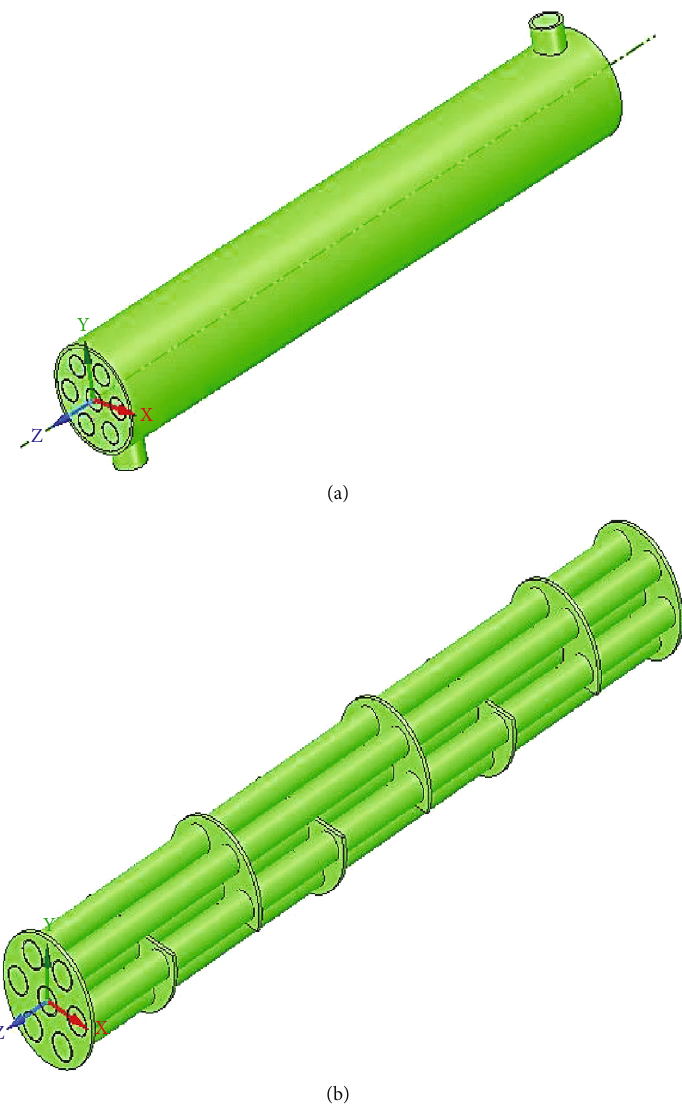
Figure 1: (a) STHX model. (b) Tube bundle arrangement with ba ffl es inside the p indicates pressure, F indicates body forces in the system, e indicates the internal energy of the fl uid, Q indicates heat transfer, t indicates the time, φ indicates dissipation, and ∇ : q indicates heat lost by conduction.